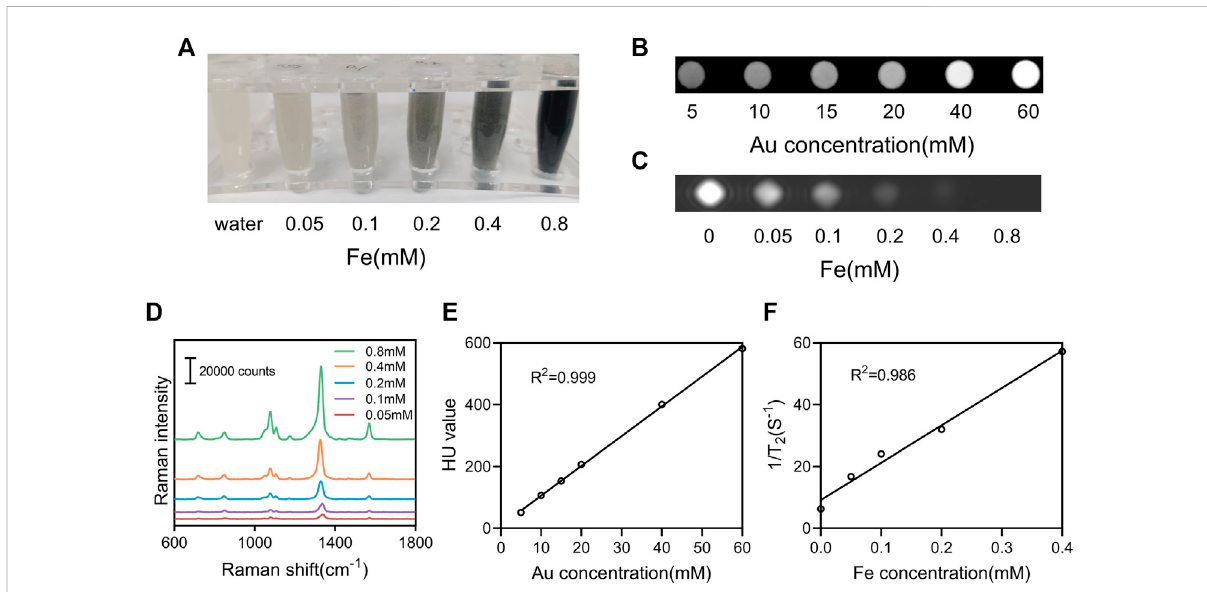
FIGURE 4 In vitro multimodal imaging of NAMs. (A) Photographs, (B) CT phantom images, (C) T 2 -weighted MRI phantom images, and (D) Raman spectra oftheNAMswithvariousconcentrations. (E) X-rayattenuation(HUvalue)oftheNAMsatdifferentAuconcentrations. (F) Ther2relaxivitylinearcurve for the NAMs at different Fe